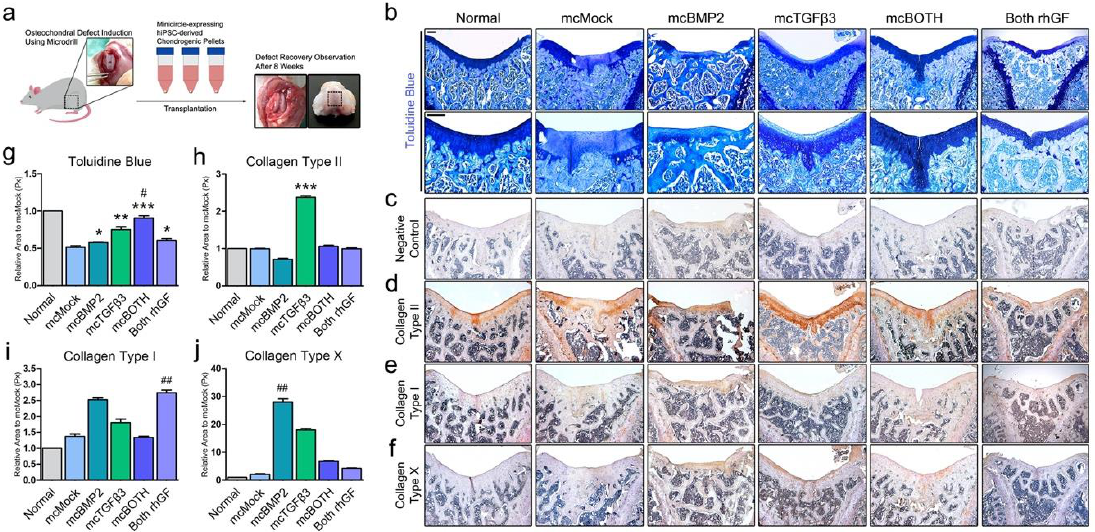
Figure 5. In vivo transplantation of minicircle-based chondrogenic pellets in the osteochondral defect rat model. ( a ) Scheme of defect induction and transplantation. ( b ) Image of pellet-transplanted joints stained with toluidine blue. The upper panel shows the 50 × magnification images and the lower panel shows a 100 × magnification images of the defect. ( c ) Image of antibody-negative control joint sections. Image of joints stained with ( d ) collagen type II, ( e ) collagen type I, and ( f ) collagen type X. ( g ) Quantification data of the toluidine blue stained area. ( h ) Quantification data of collagen type II. ( i ) Quantification data of collagen type I. ( j ) Quantification data of collagen type X. The scale bar represents 200 µ m. * p < 0.05; ** p < 0.01; *** p < 0.001 vs. mcMock (t-test), # p < 0.05; ## p < 0.01 vs. normal (one-way Anova) indicate significance. mcMock: minicircle mock vector-transfected outgrowth cells; mcBMP2: minicircle BMP2-encoding vector-transfected outgrowth cells; mcTGF β 3: minicircle TGF β 3-encoding vector-transfected outgrowth cells; mcBOTH: 1:1 mixture of mcBMP2- and mc TGF β 3-transfected outgrowth cells; Both rhGF: both recombinant human BMP2 and TGF β 3 growth factor protein-treated outgrowth cells.